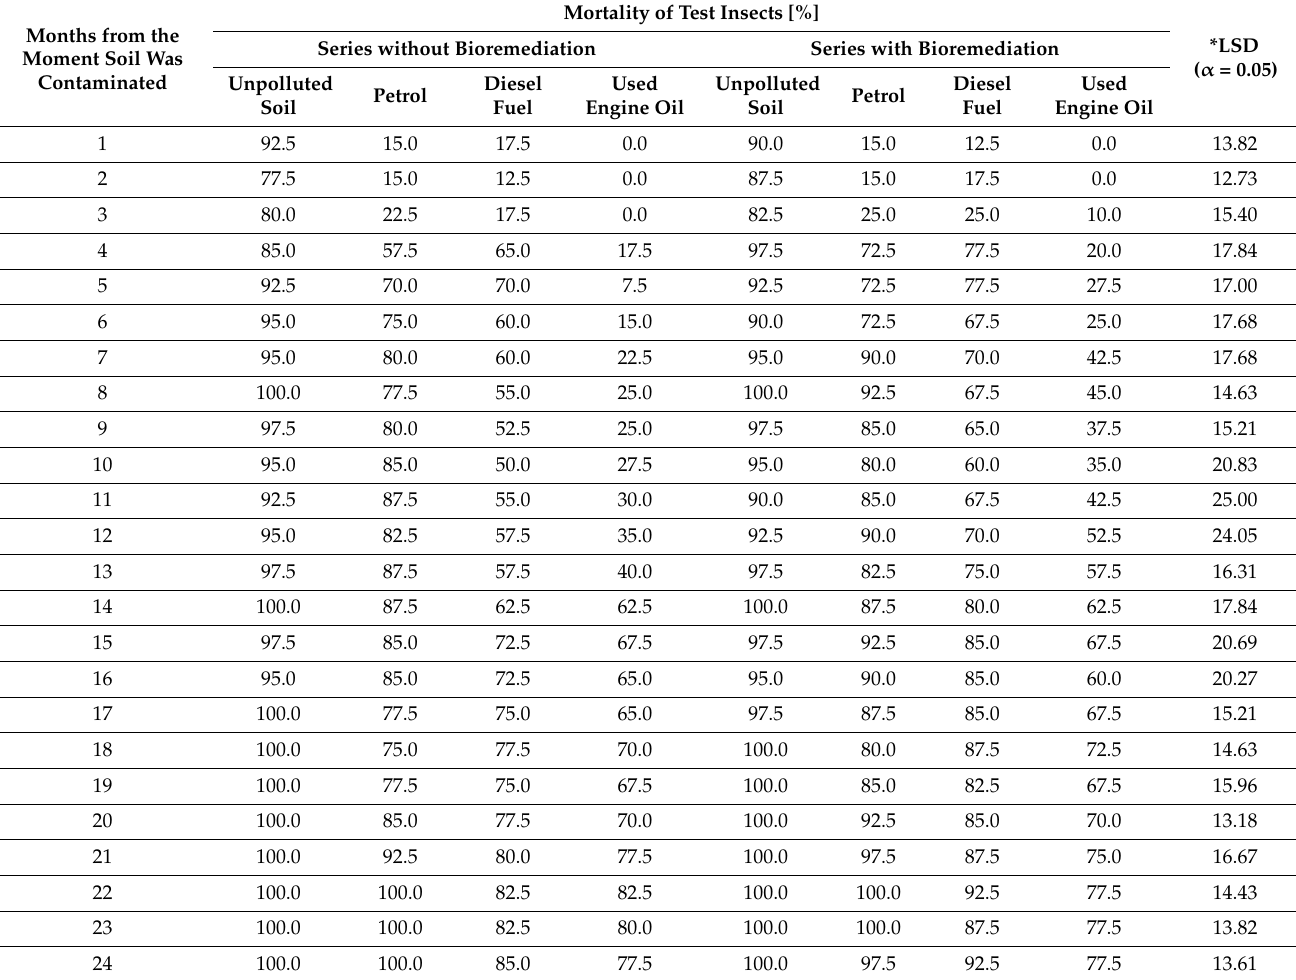
Table 1. The effect of oil derivatives on the virulence of S. feltiae —presented as the mortality of test insects (larvae of T. molitor